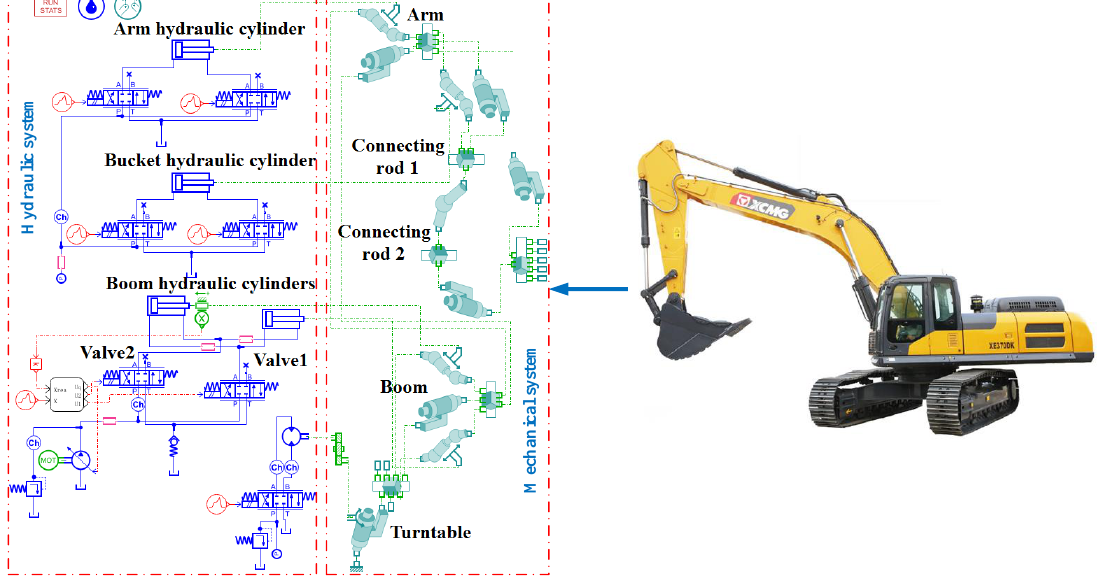
Figure 14. Image of the 37 ton IMC excavator model.